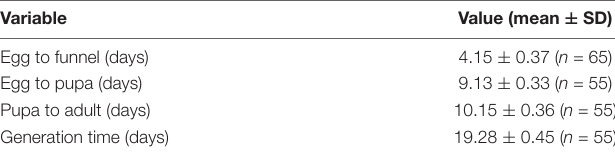
TABLE 2 | Developmental period of E. japonica on the fifth instar B. mori .